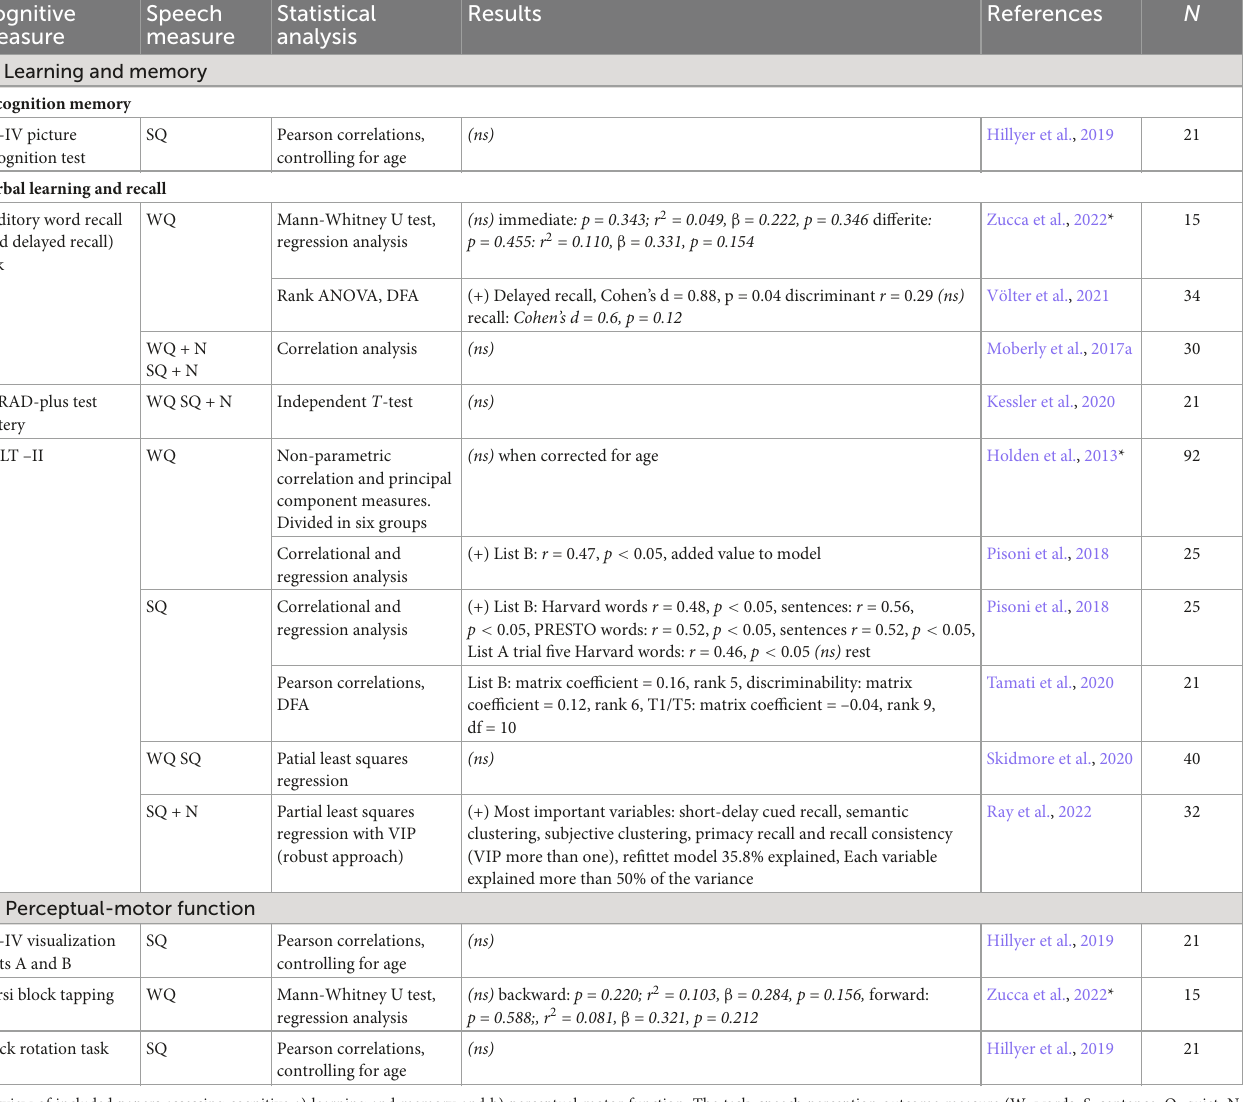
TABLE 10 Overview of included papers studying learning and memory and perceptual motor